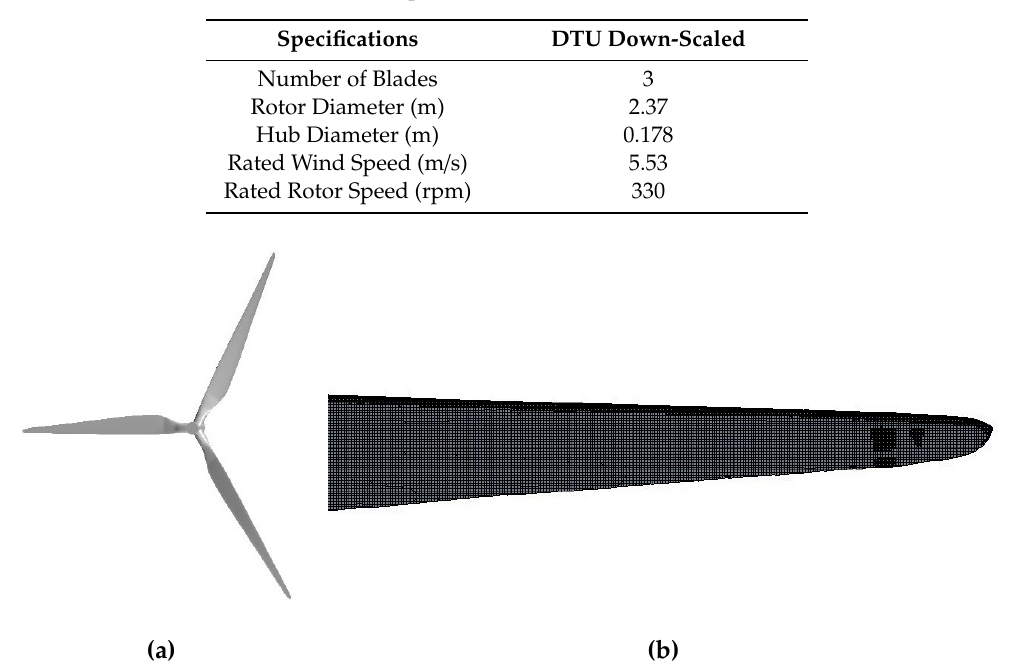
Table 1. Principal dimensions of the scale model.